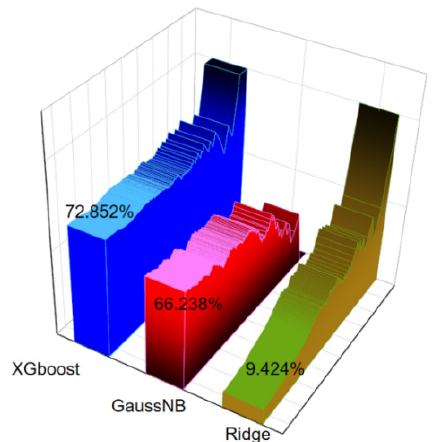
Figure 4. Disturbance offset prediction accuracy of three methods.